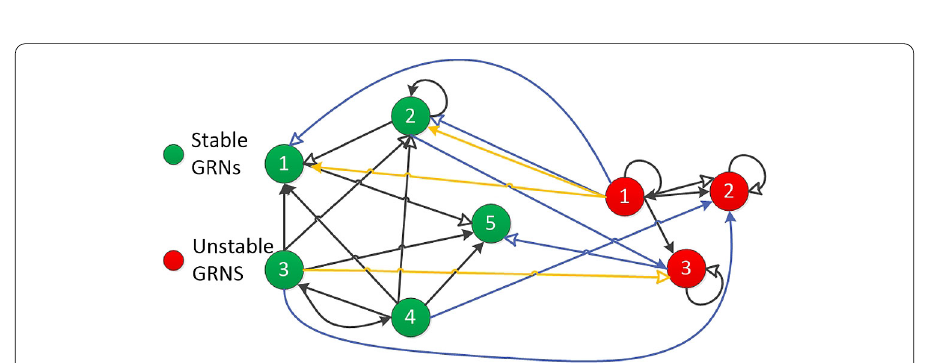
Figure 9 The topological structure of interactional GRNs.